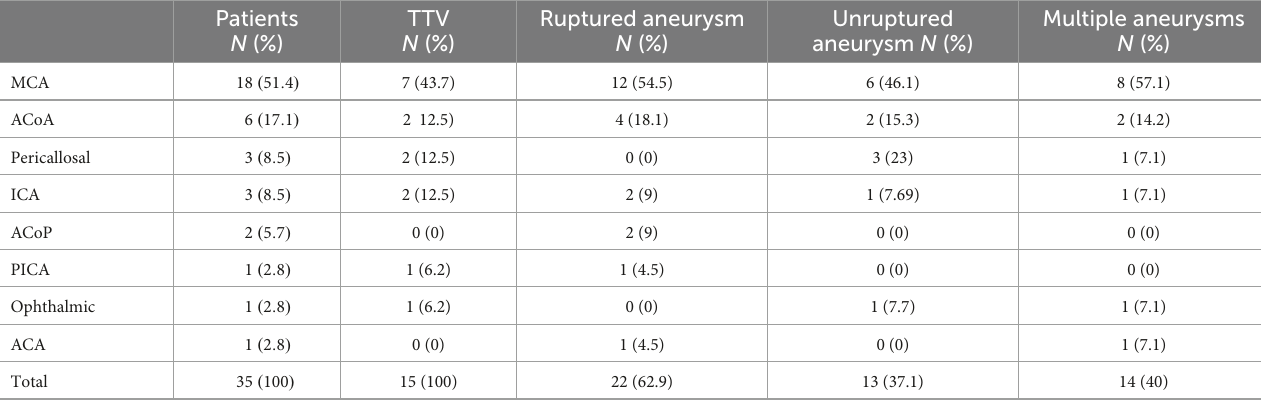
TABLE 3 Aneurysm